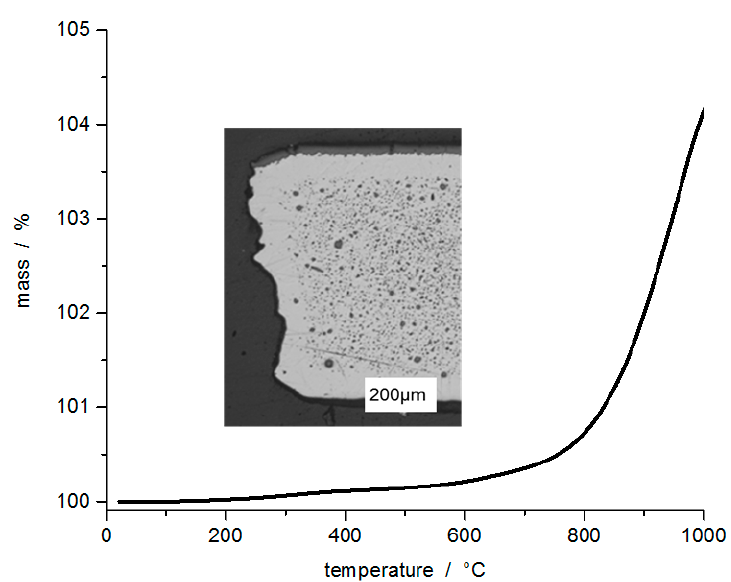
Figure 3. Oxidation of 17-4PH steel in air and the sintered 17-4PH/YSZ laminate.